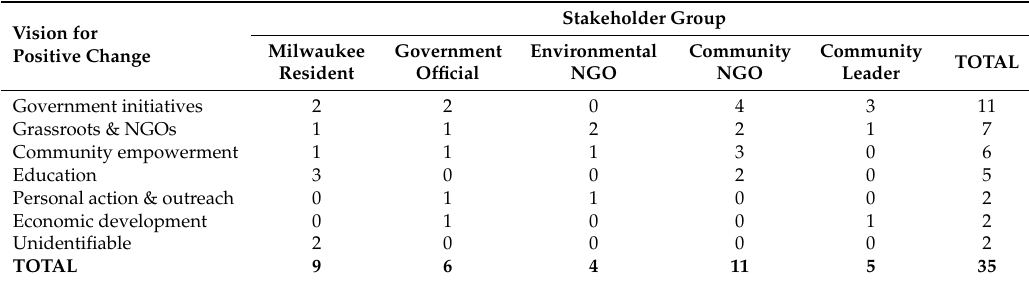
Table 4. Stakeholder affiliation and their vision for positive